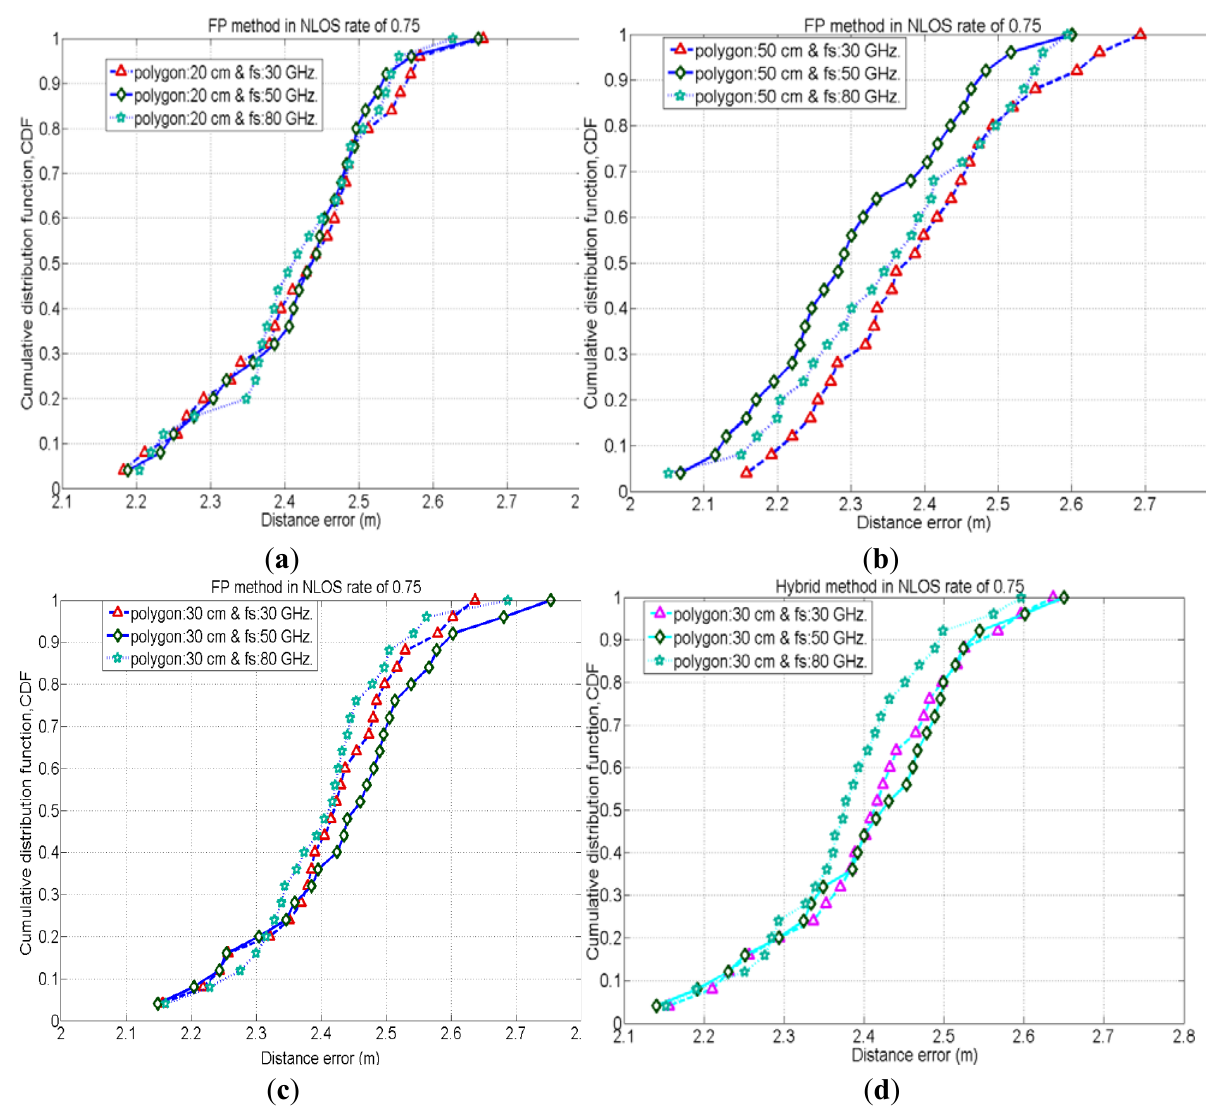
Figure 8. CDF of the distance errors for FP method (8 a - c ), Hybrid method (8 d ) in different cases with NLOS rate =